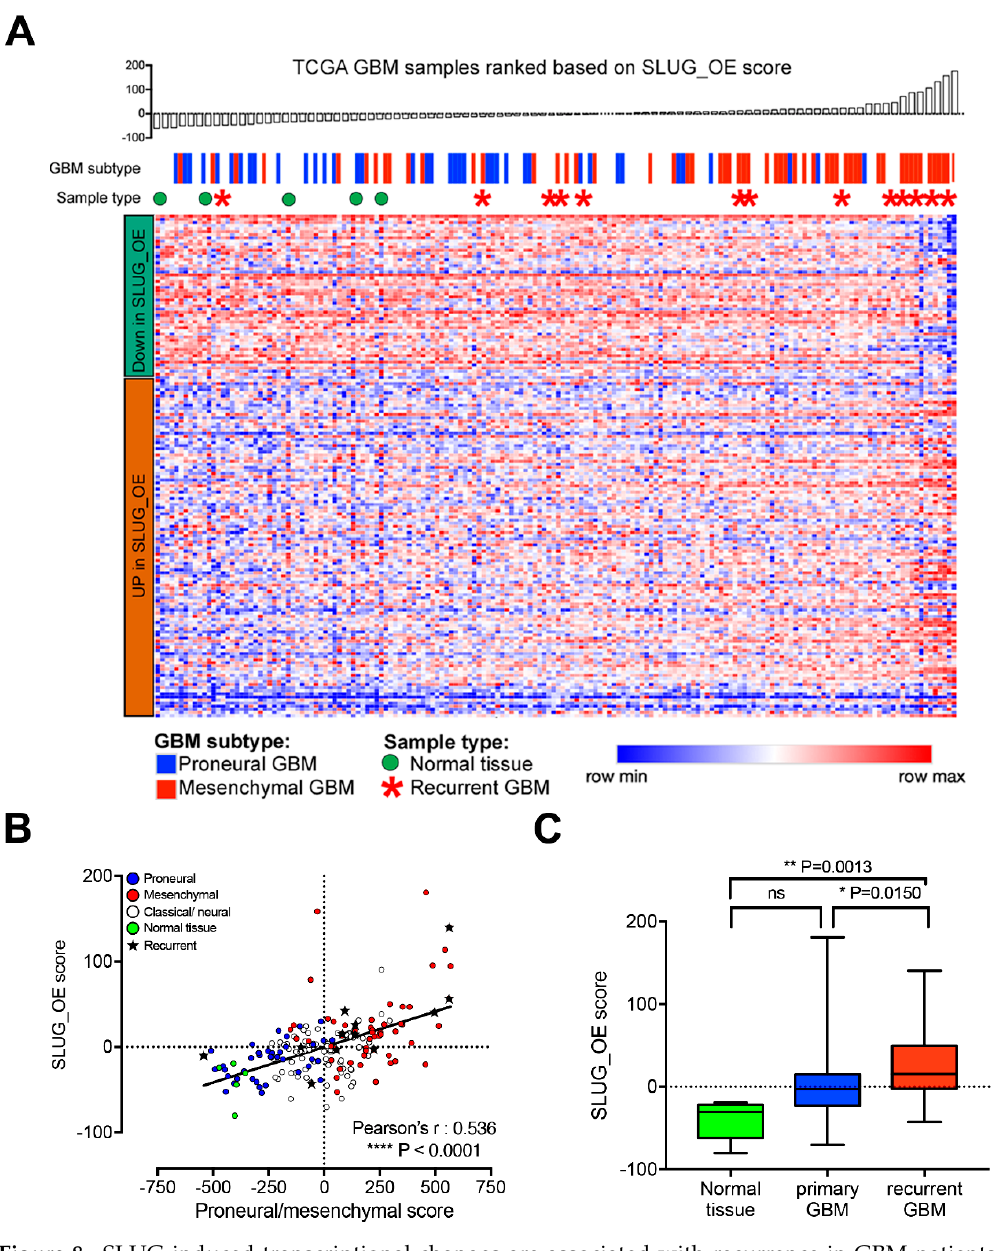
Figure 8. SLUG-induced transcriptional changes are associated with recurrence in GBM patients. ( A ) Heatmap representing the expression of the 180 genes of the SLUG_OE score in 172 TCGA GBM samples. Samples were ranked according to the SLUG_OE score. ( B ) Scatter plot showing correlation between the SLUG_OE score and the proneural to mesenchymal score and association with recurrent samples (annotated with a star). ( C ) Box and whiskers plot (min to max) showing increased SLUG_OE score in recurrent compared primary GBMs and normal brain tissue samples.